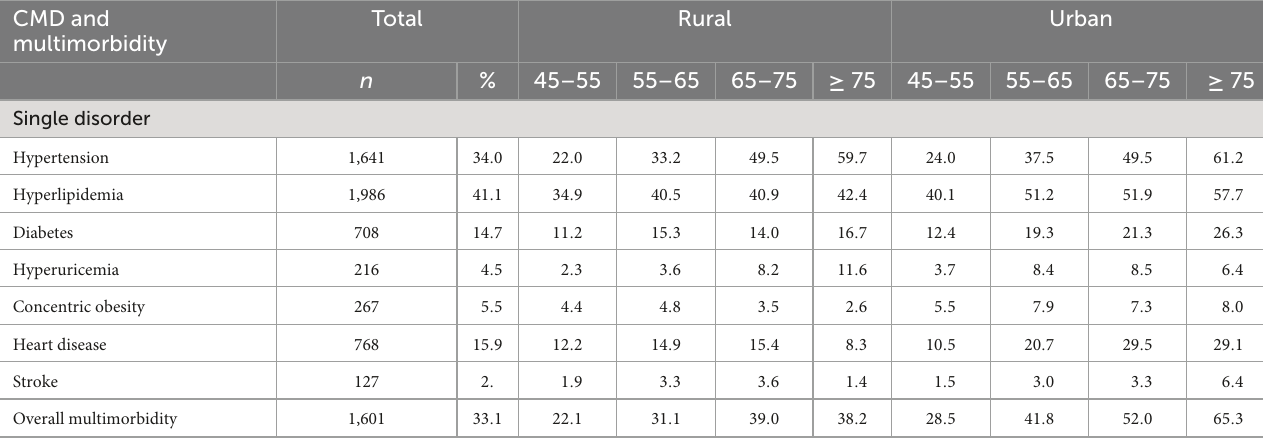
TABLE 2 The proportion of cardiometabolic diseases and multimorbidity among Chinese adults by age group and residence place ( N = 4,832). CMD and Total multimorbidity